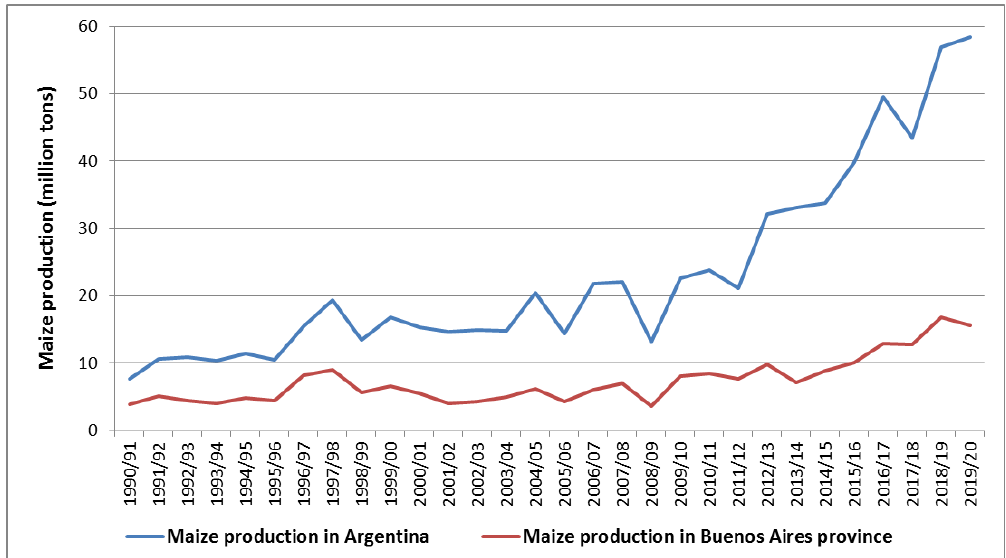
Figure 1. Maize production in Argentina and Buenos Aires province. Source: Ministry of Agriculture, Livestock and Fisheries of Argentina, 2020.